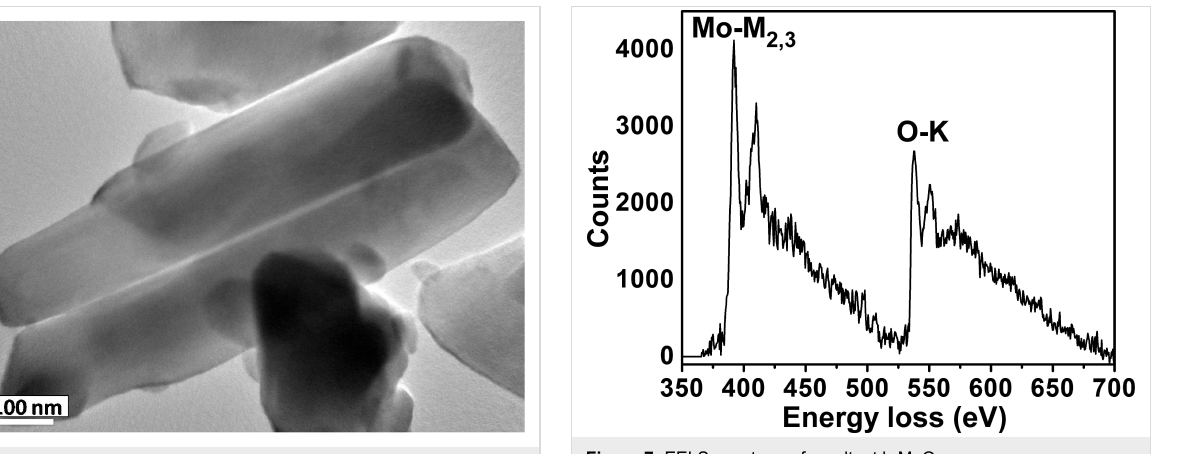
Figure 6 shows the HRTEM image and the inset is the corres- ponding SEAD pattern of h-MoO 3 . From the lattice resolved HRTEM image, the distance between the two planes was found to be 0.345 nm, belonging to the (210) plane of h-MoO 3 . The electron diffraction, with a highly intense dotted pattern, reveals the single crystalline nature of h-MoO 3 . Furthermore, the elemental composition and chemical bonding information were confirmed by EELS investigation.